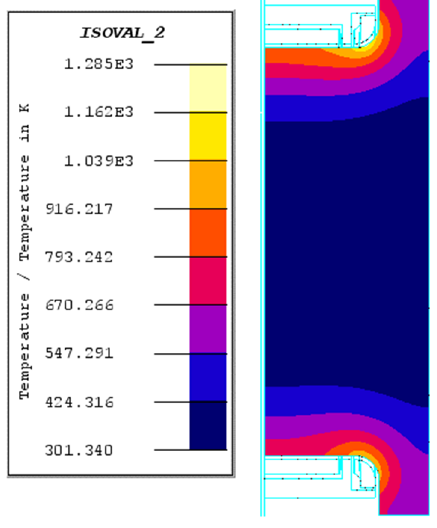
Figure 15. Temperature field of crankshaft N1 during the heating stage (T = 12S).